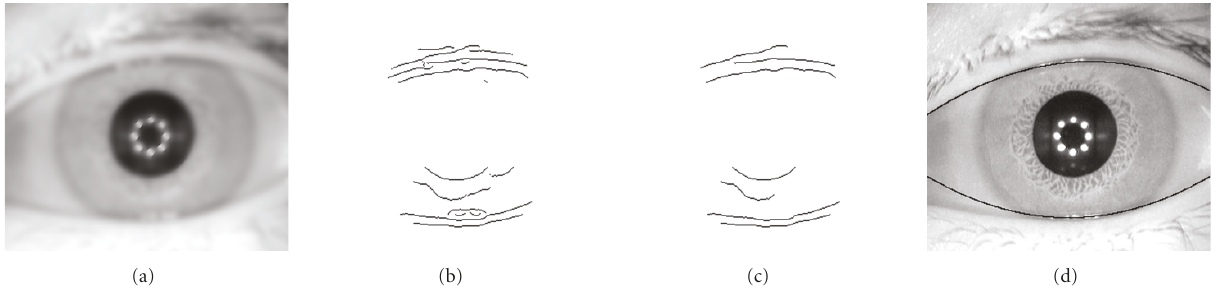
Figure 5: Occlusion localization. (a) Preprocessed image, (b) selected edges to be fitted by a parabola,(c) final candidate selection, and (d) edge detection after